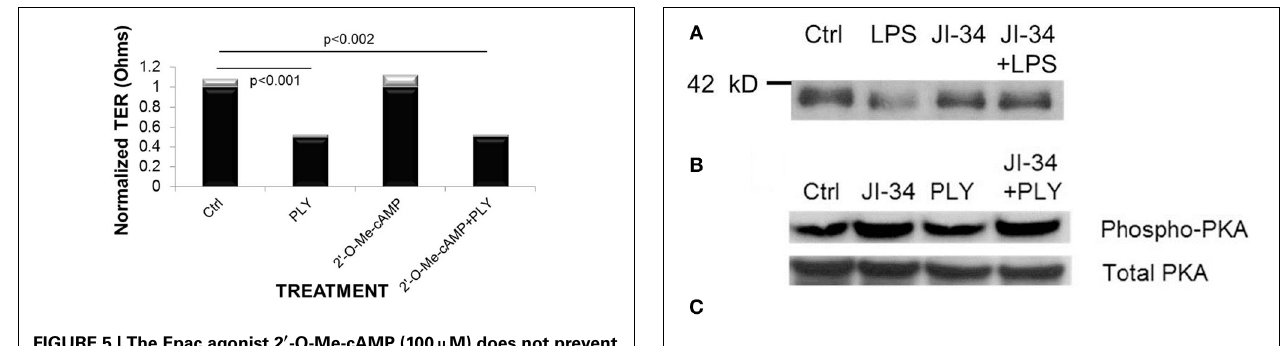
FIGURE 5 | The Epac agonist 2 (cid:2) -O-Me-cAMP (100 μ M) does not prevent PLY (30ng/ml)-mediated hyperpermeability, measured as normalized transendothelial electric resistance (TER) in HL-MVEC (ECIS, n = 4, 6h). Mean ± SD (gray bars).